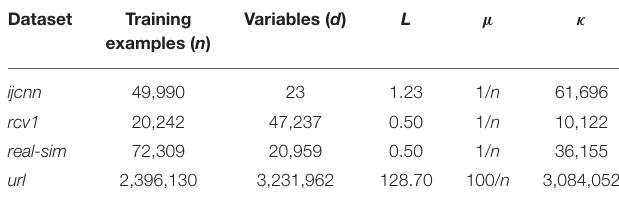
TABLE 4 | Datasets used in the